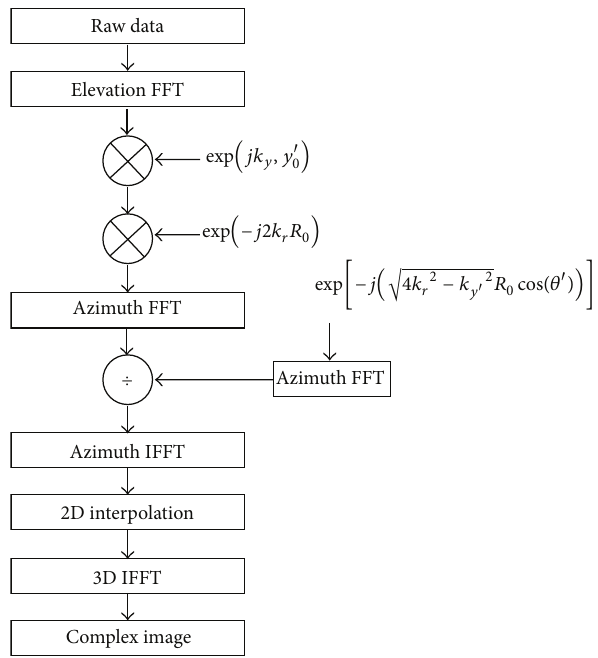
Figure 2: Scheme of the wavenumber domain